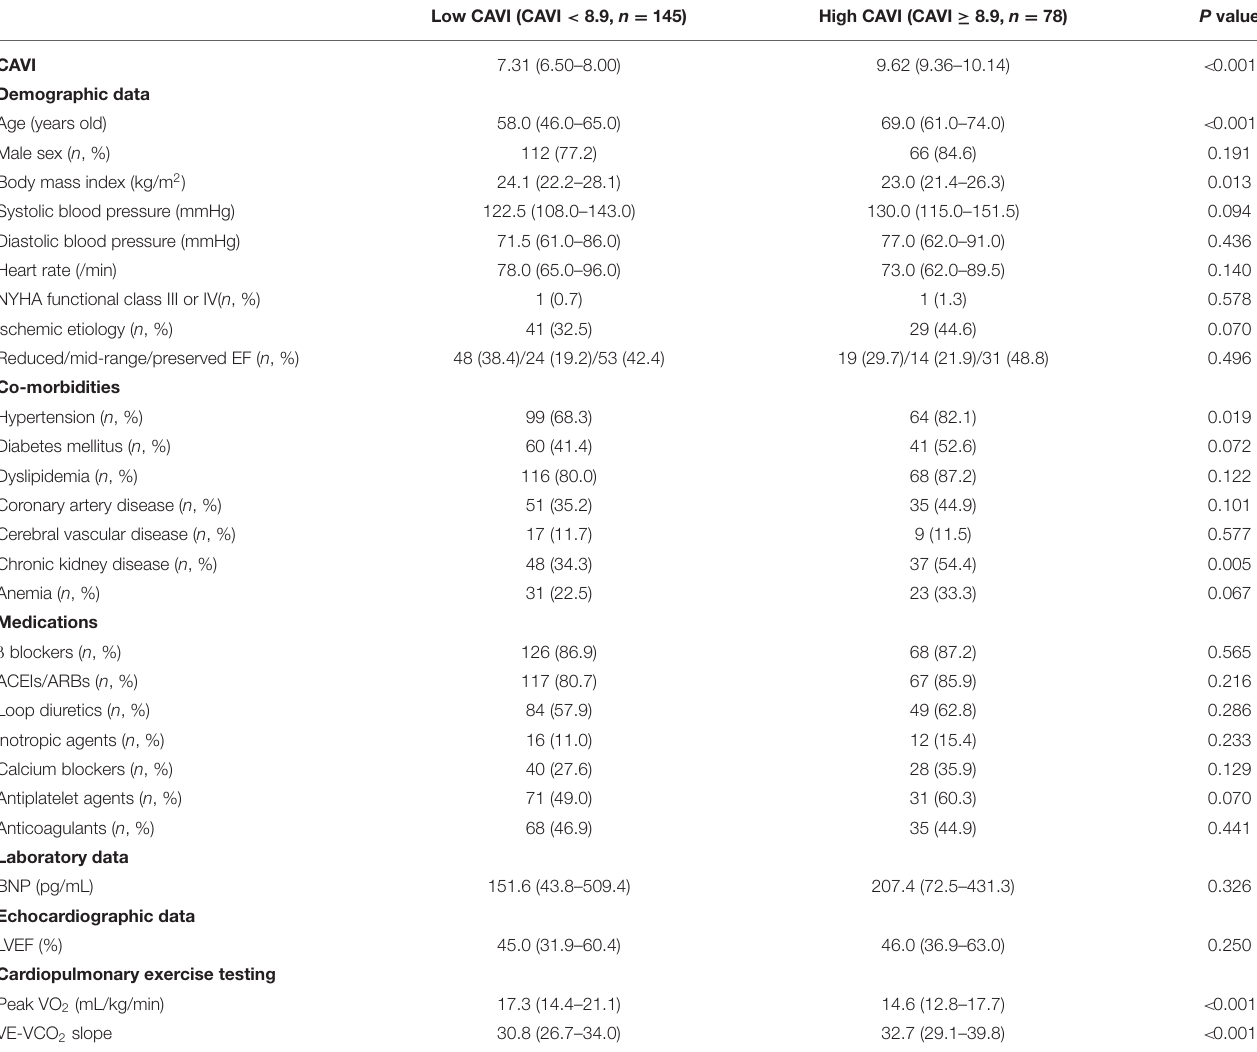
TABLE 1 | Baseline patient